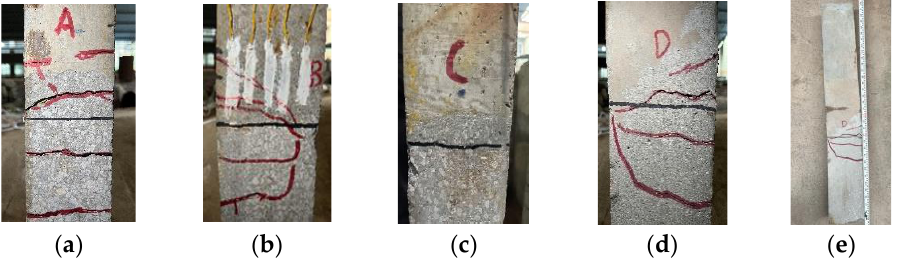
Figure 13. Crack distributions along the test pile. ( a ) Side A; ( b ) Side B; ( c ) Side C; ( d ) Side D; ( e ) Pile.